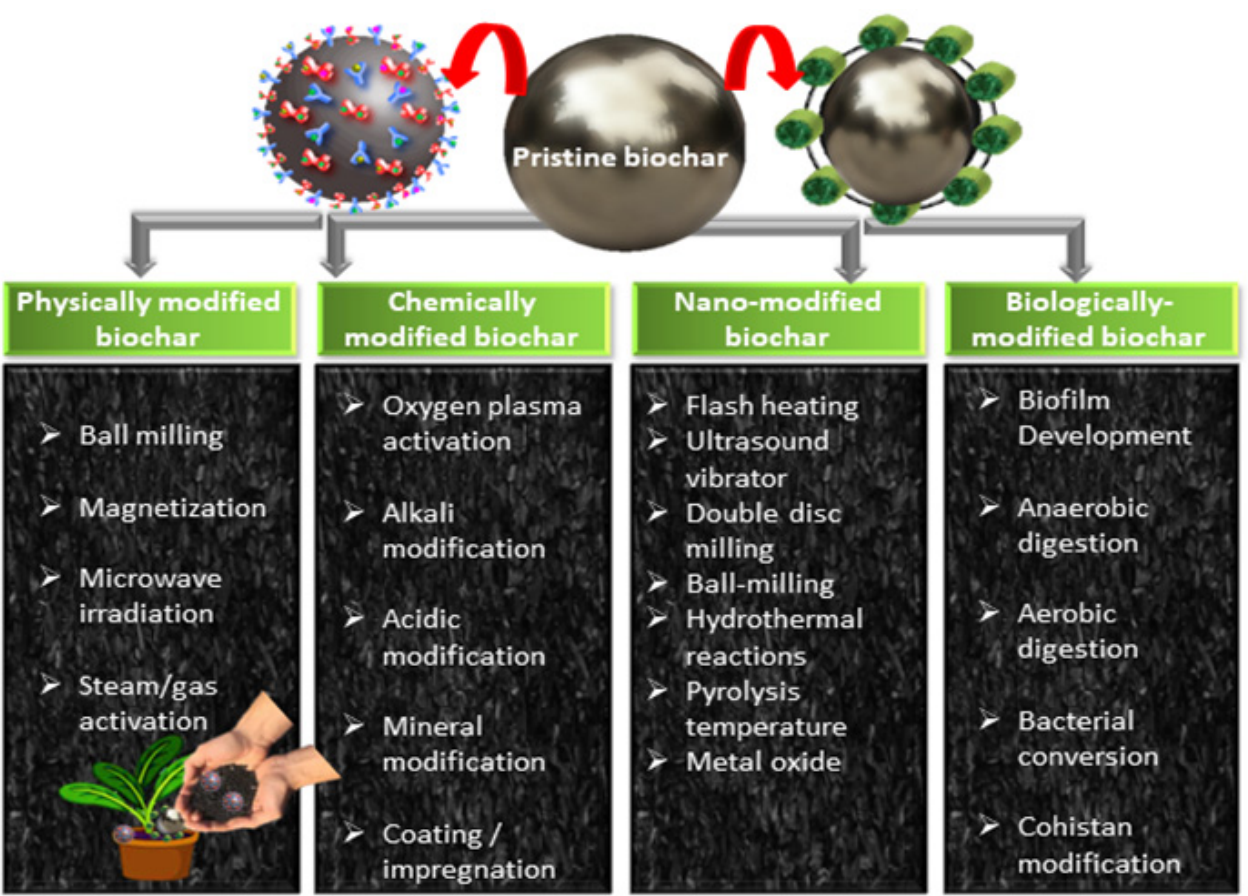
Figure 1. Depiction of different ways for conversion of pristine biochar to modified biochar for improving soil quality.